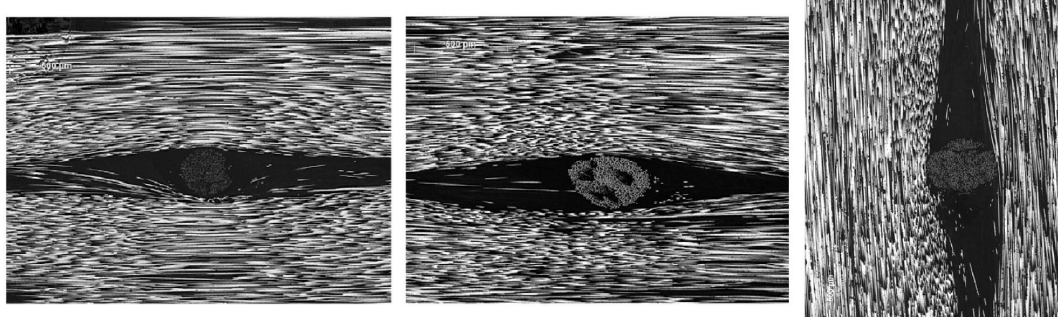
Figure 11. Resin rich zone of z-Pin inserted in quasi-isotropic laminate (left to right): ( a ) 0 ◦ o ff set z-Pin, ( b ) 45 ◦ inclined z-Pin on a 0 ◦ ply and ( c ) 45 ◦ inclined z-Pin on a 90 ◦ ply